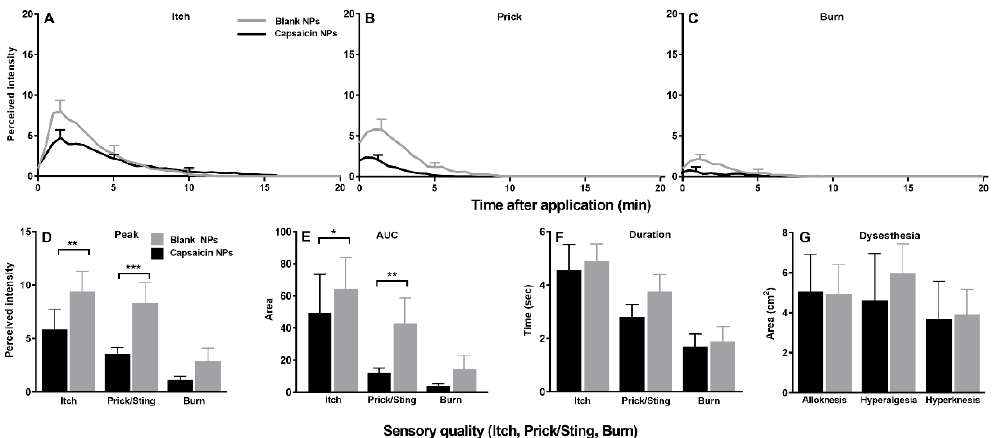
Figure 7. Effects of capsaicin NP pretreatment on sensations and dysesthesias evoked by injection of beta alanine. ( A – C ) Time course of perceived intensities of itch, pricking/stinging and burning. Same format as Figure 7. ( D ) Peak magnitude (Peak) of each sensory quality. ( E ) Area under the rating curve (AUC). ( F ) Duration of response. ( G ) Area of each type of dysesthesia: alloknesis, hyperalgesia and hyperknesis. n = 21, ( A – C ) repeated measures two-way ANOVA; two repeated treatment groups (capsaicin vs. placebo treatment) × 40 repeated timepoints (0–20 min) with Bonferroni correction, ( D – G ) Wilcoxon test. Data are means with SEMs. * p < 0.05 and ** p < 0.01and *** p < 0.001.